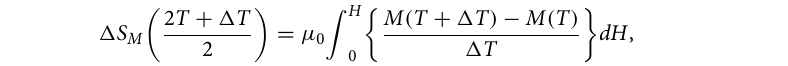
With the isothermal magnetization measurement results from 170 to 210 K presented in Fig. 3b, the magnetic entropy change (cid:31) S M is thus estimated by the following formula: